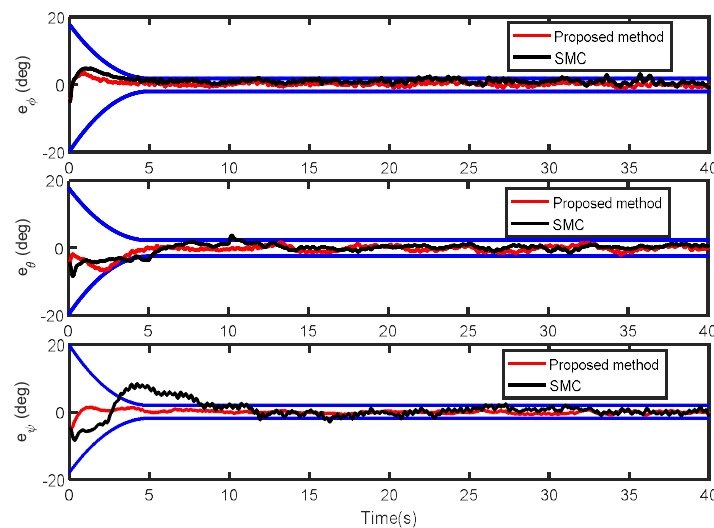
Figure 13. Comparisons of angle tracking errors with SMC. Table 5. Quantitative analysis between proposed method and SMC in